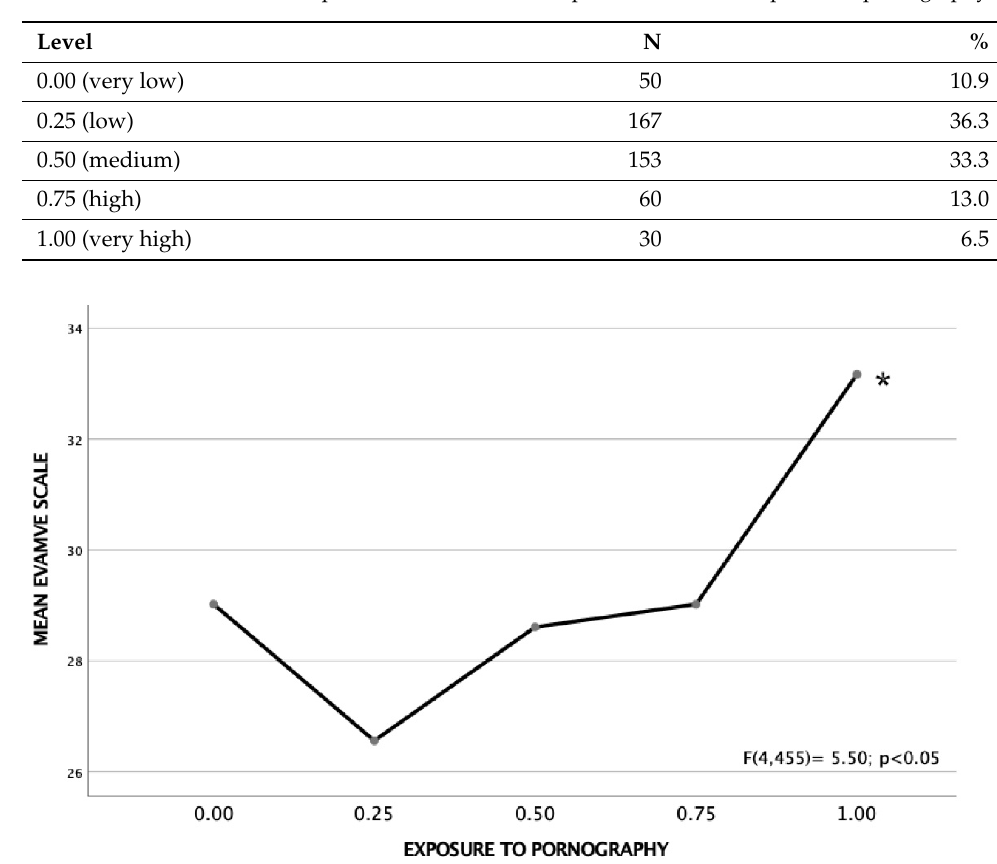
Table 5. Distribution of the sample in the levels of the independent variable “Exposure to pornography”.